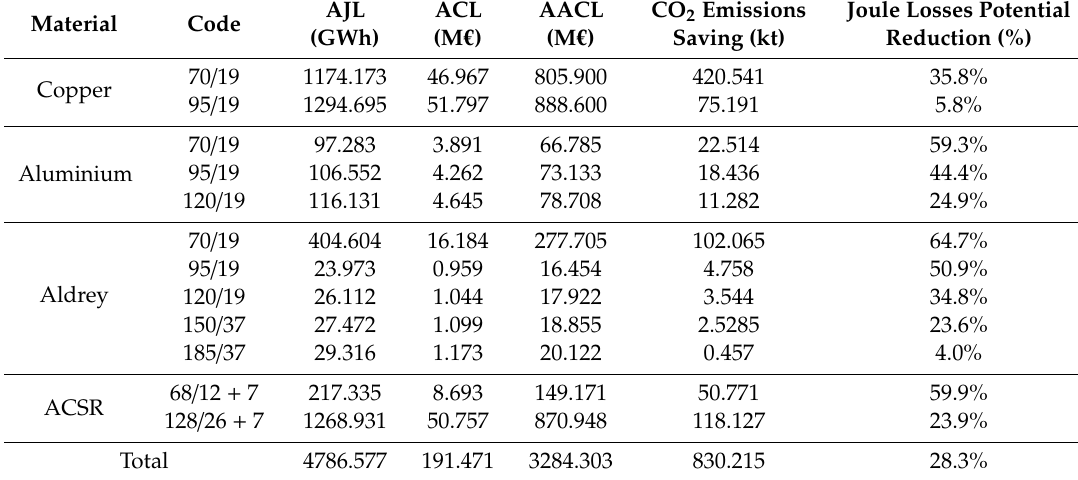
Table 15. Total cost for each traditional conductor in the study and expected benefit using the innovative